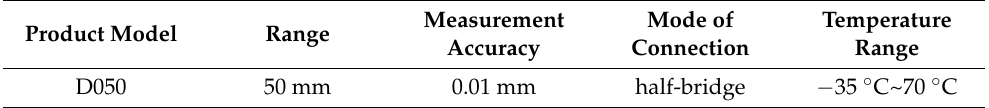
Table 3. Parameters of displacement